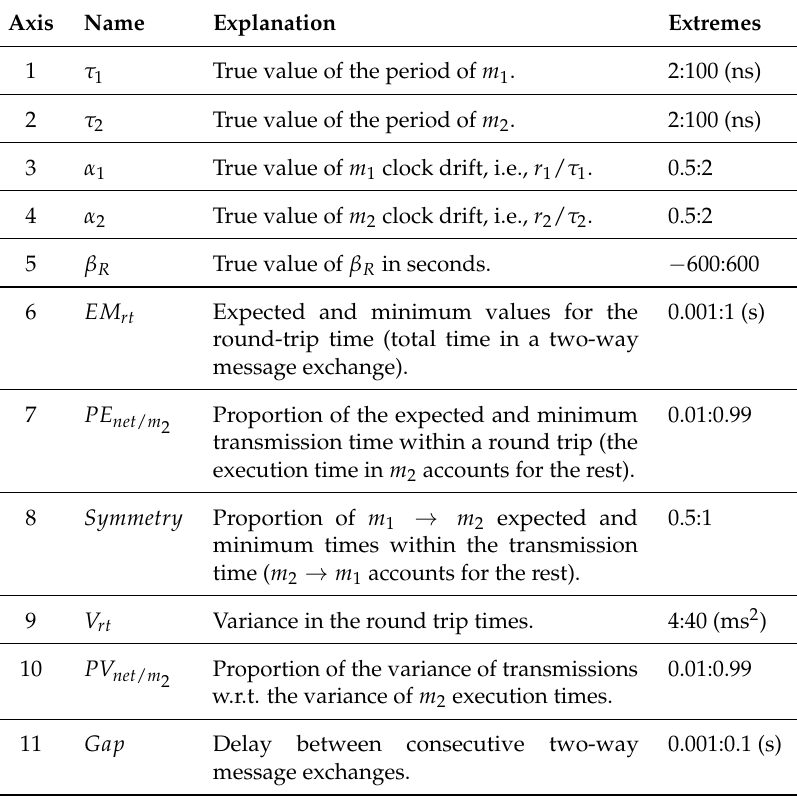
Table 1. Configuration axes for defining a pairwise scenario in simulation. r i is the nominal clock period and τ i the actual